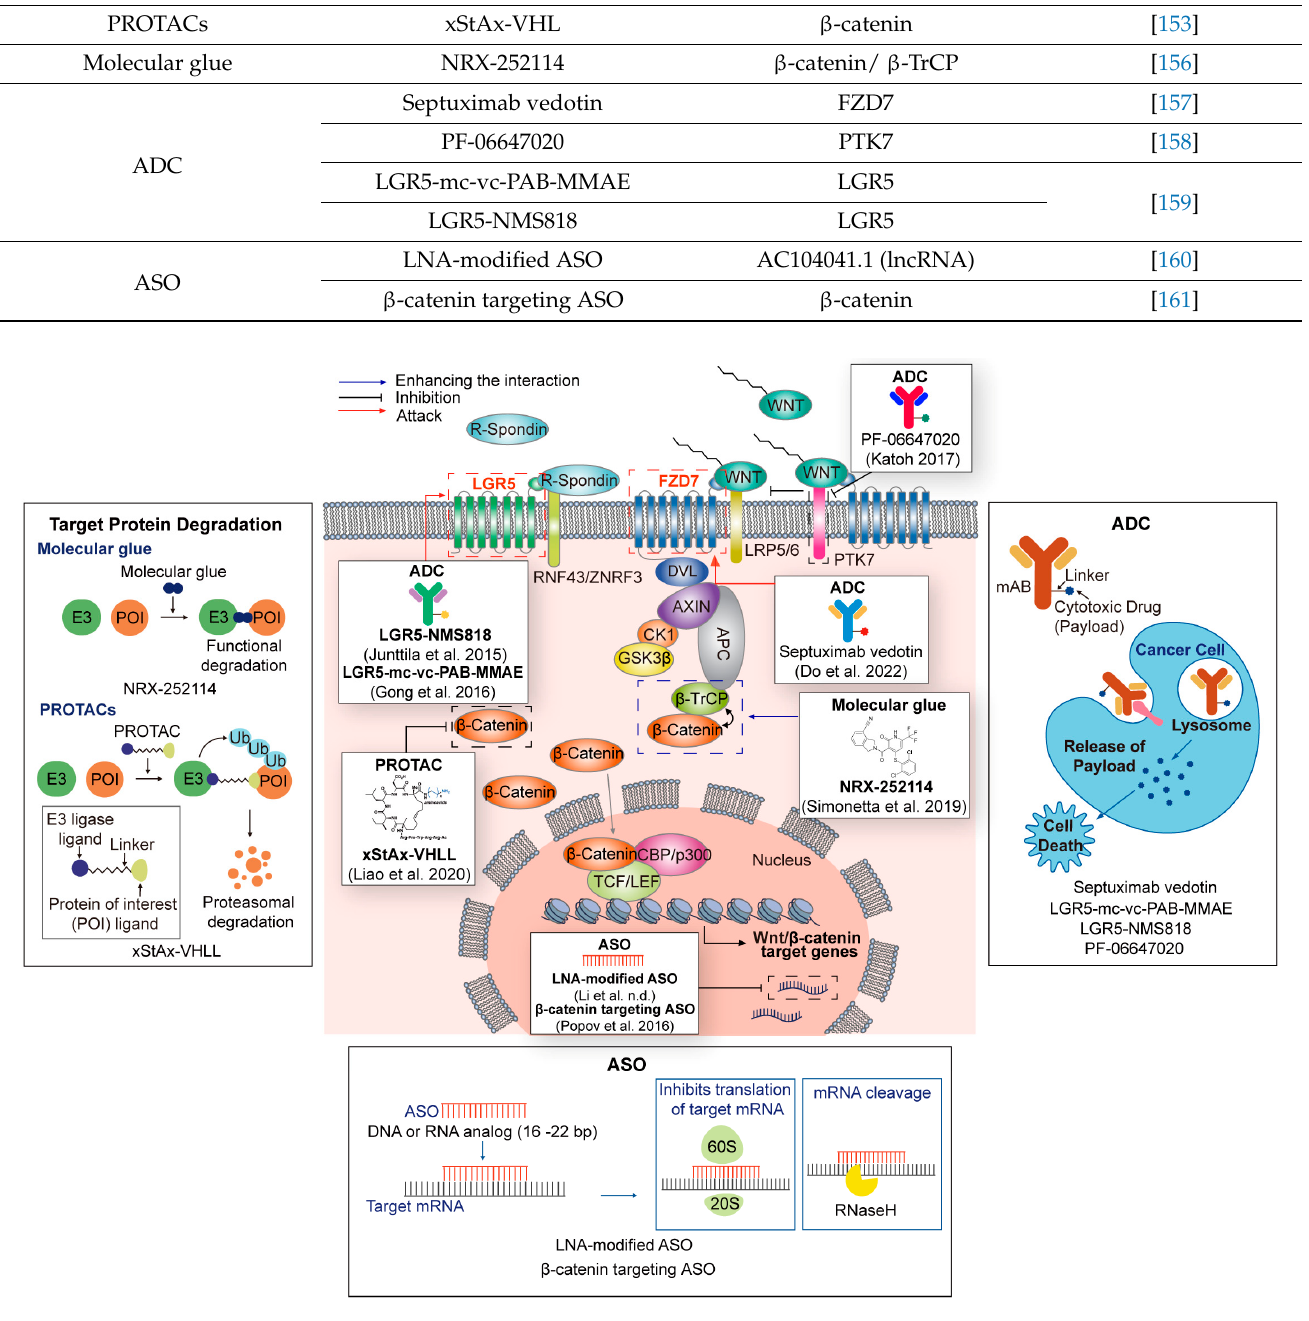
Figure 3. Targeting Wnt signaling pathway by the latest technologies. β -catenin targeted PROTACs (xStAx-VHL) recruits E3 ligase to β -catenin, inducing the degradation of β -catenin using the ubiquitin–proteasome system. Additionally, the molecular glue of β -catenin and its E3 ligase β -TrCP, NRX-252114, enhances the β -catenin degradation. ADCs (LGR5-mc-vc-PAB-MMAE, LRG5- NMs818, and PF-06647020) targeting LGR5- or PTK7-expressing Wnt responder cells bind to the target cells and release a cytotoxic drug to induce the cell death. ASO (LNA-modified ASO, β - catenin targeting ASO) binds to the target region of RNA and suppresses expression. Table 3. Wnt signaling targeting agents using the latest technologies (PROTACs, ADC, and ASO). Technologies